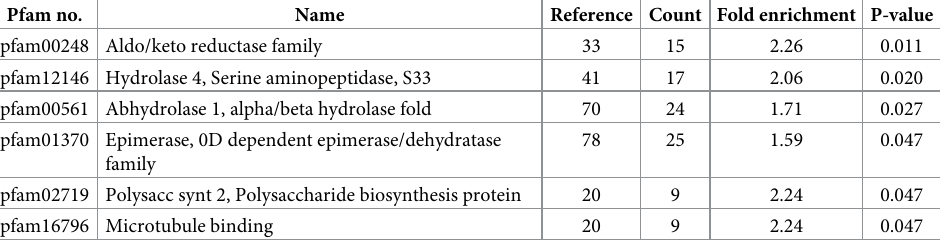
Table 4. Enrichment analysis of Pfam protein domains among the 2,505 targets that exhibited differential expres- sion patterns between the three sites. Pfam